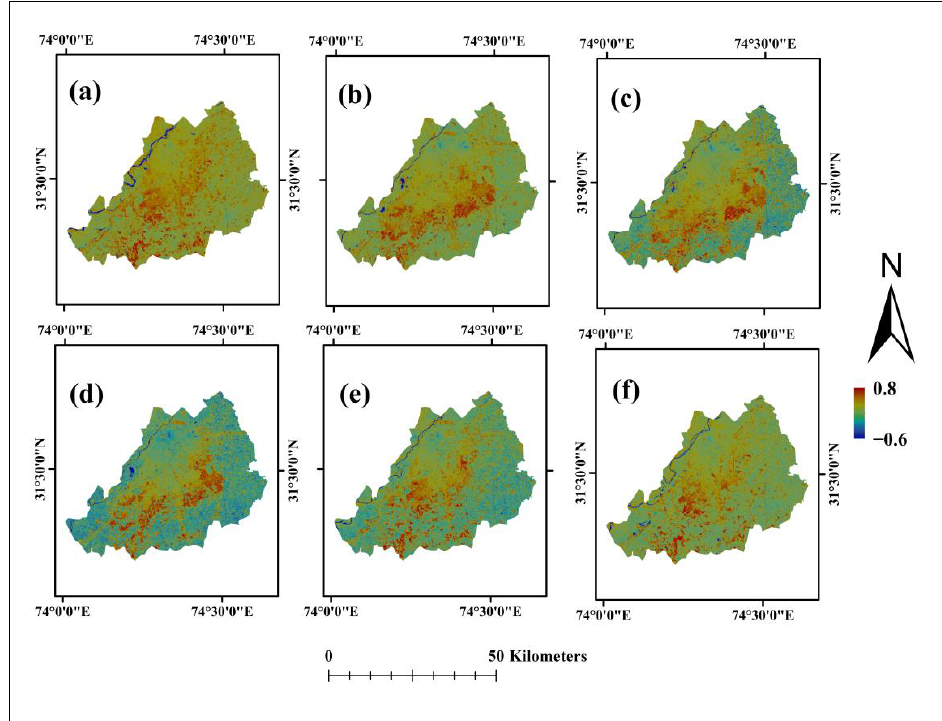
Figure 6. NDBaI map of Lahore for year ( a ) 1992, ( b ) 1996, ( c ) 2000, ( d ) 2008, ( e ) 2014, and ( f ) 2020.